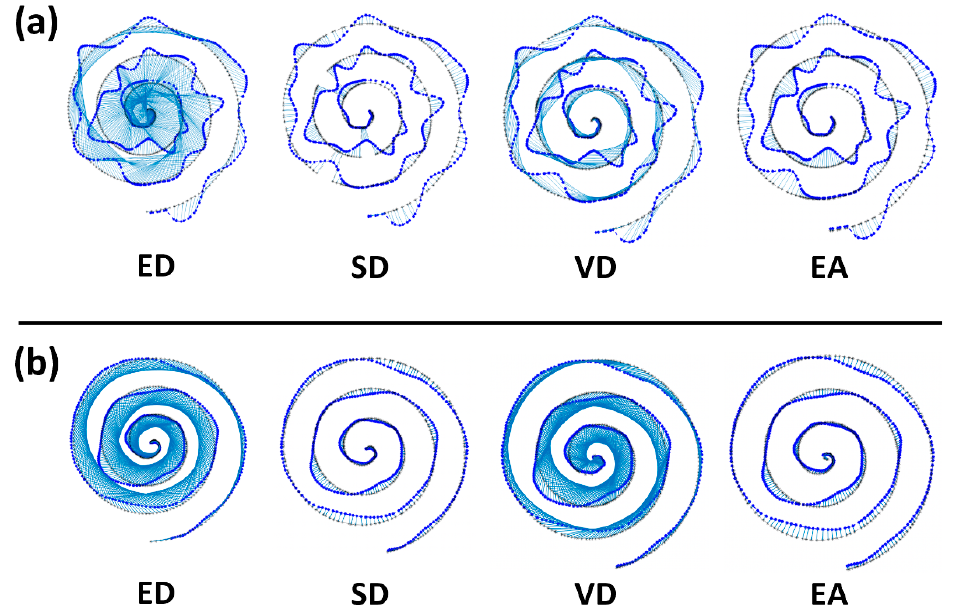
Figure 5. Representative drawing results of simulation ( a ) and experiment ( b ). In each figure, the base spiral pattern (black) and the drawing (blue) are presented, and estimated pairs between the spiral and the drawing are marked in light blue lines. Some meaningful mismatches are marked with blue rectangles.